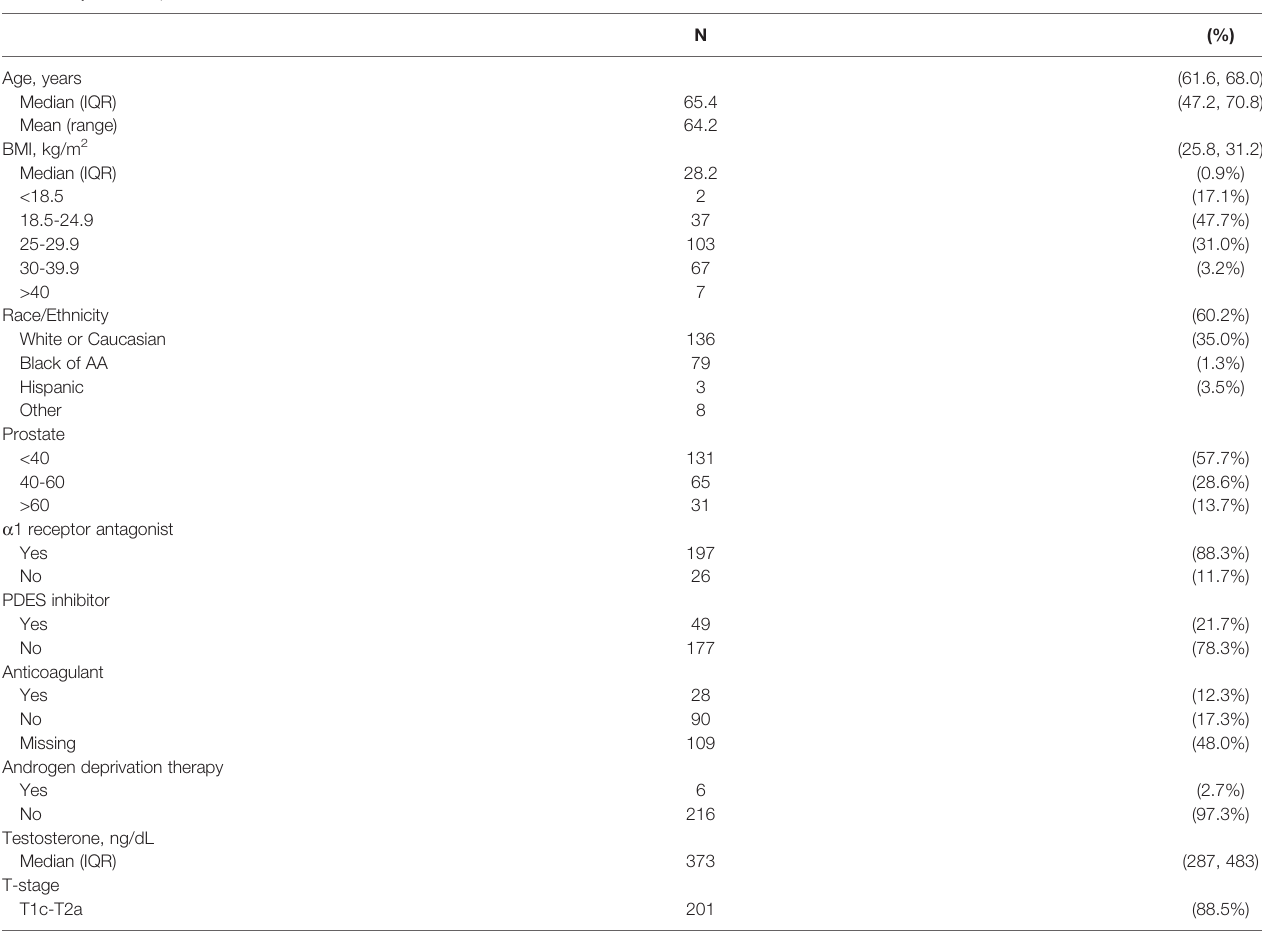
TABLE 1 | Baseline patient, disease, and treatment